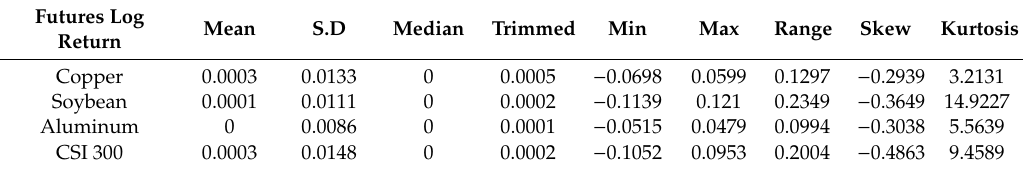
Table 2. Summary statistics of daily futures